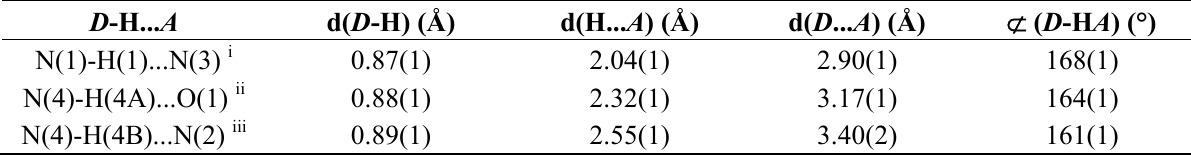
Table 3. Interatomic distances and geometries for hydrogen bonds in the crystal structure of 2